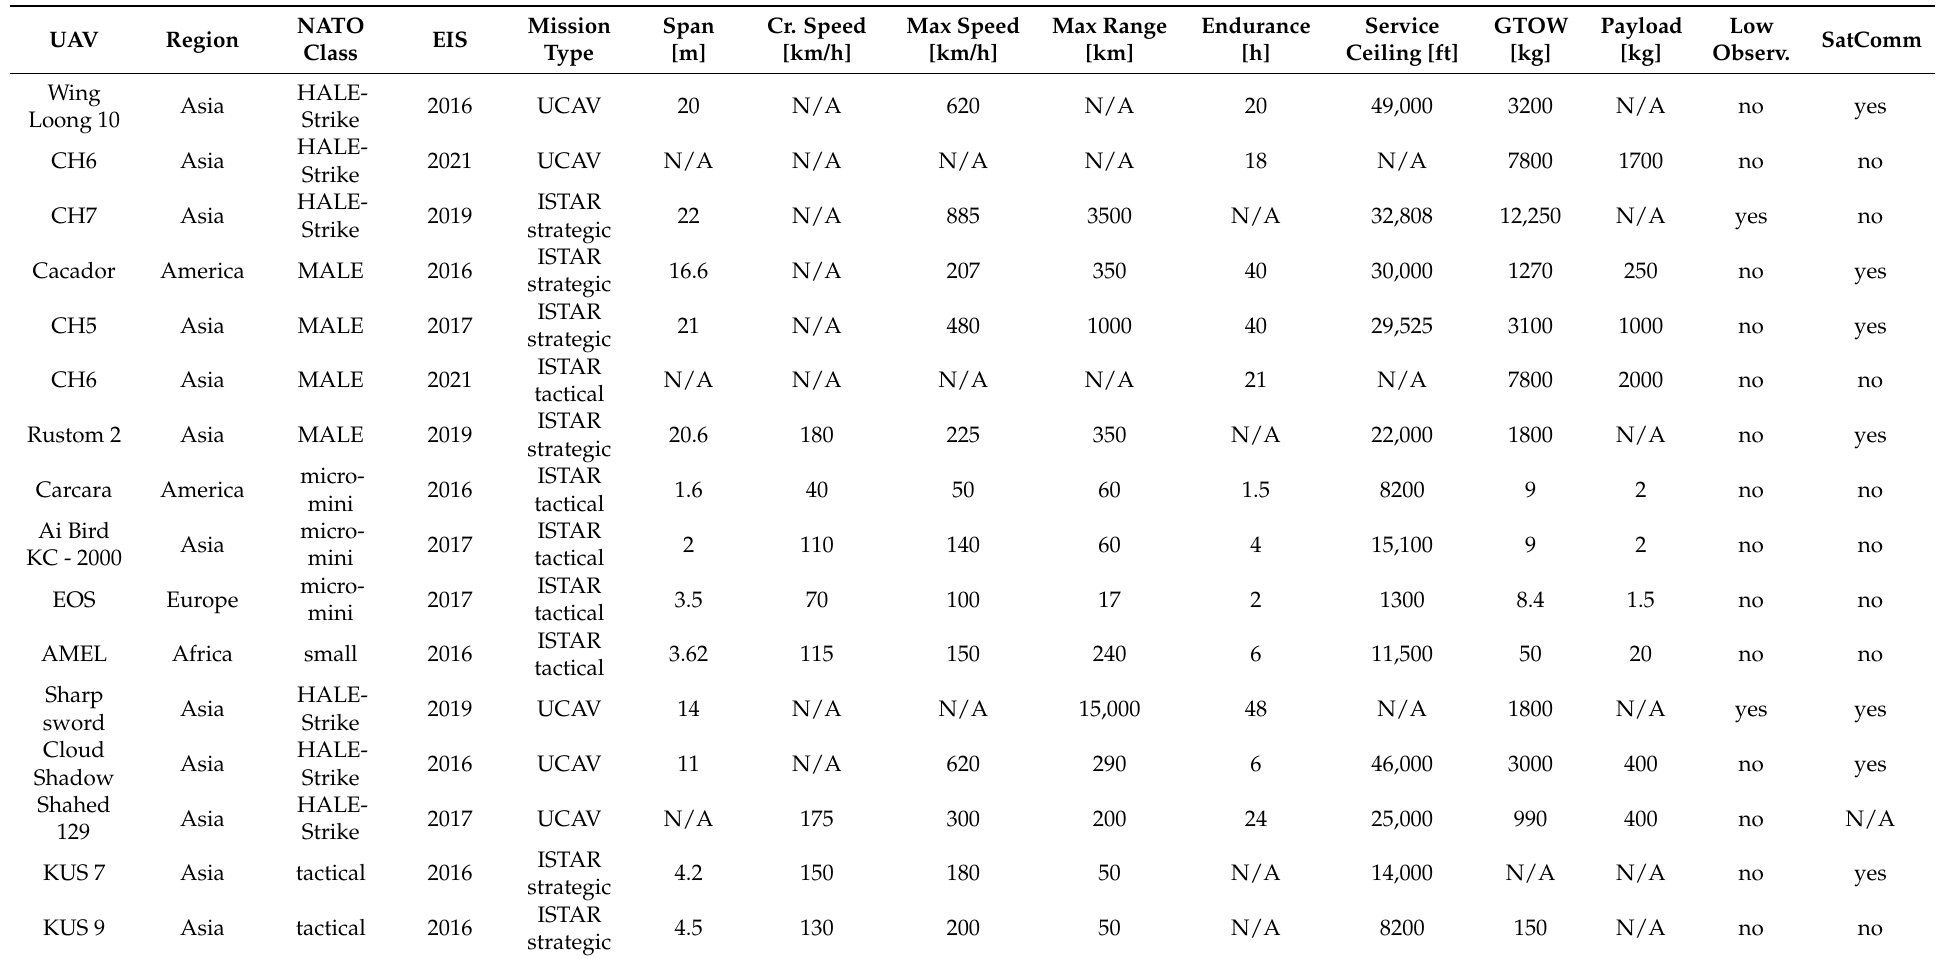
Table A1. UAVs models that entered into service after 2015 and their respectivre